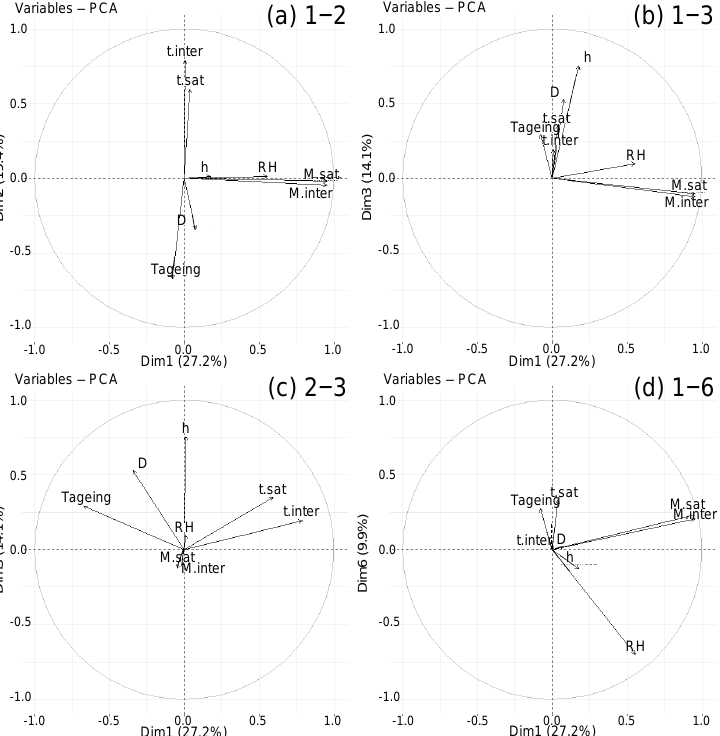
Figure 8. Correlation circles on planes ( a ) 1–2, ( b ) 1–3, ( c ) 2–3 and ( d ) 1–6 of the global